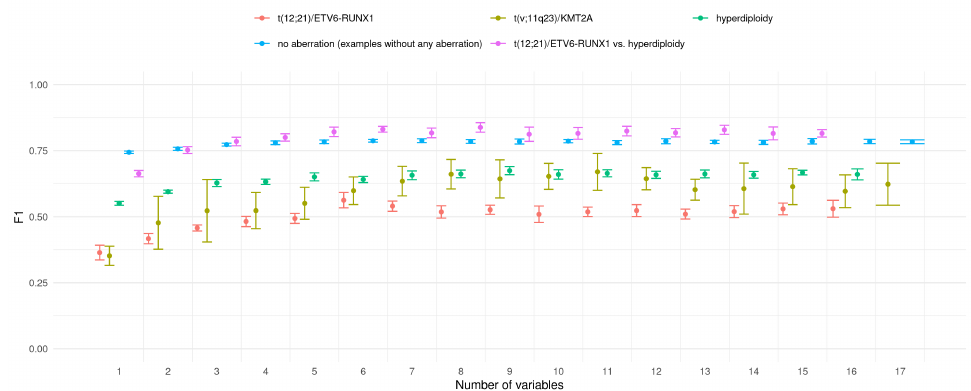
Figure 5. F1 values for classifiers with increasing number of features (mean +/ − standard deviation). Each successive classifier uses one more feature than the previous one (i.e., classifier 5 uses all the